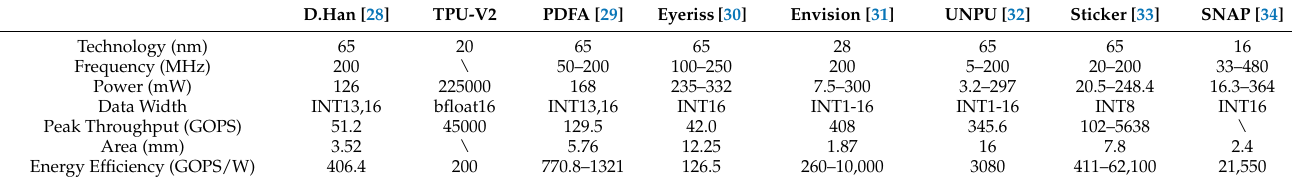
Table 2. Performance comparison of state-of-the-art FPGA-based accelerator